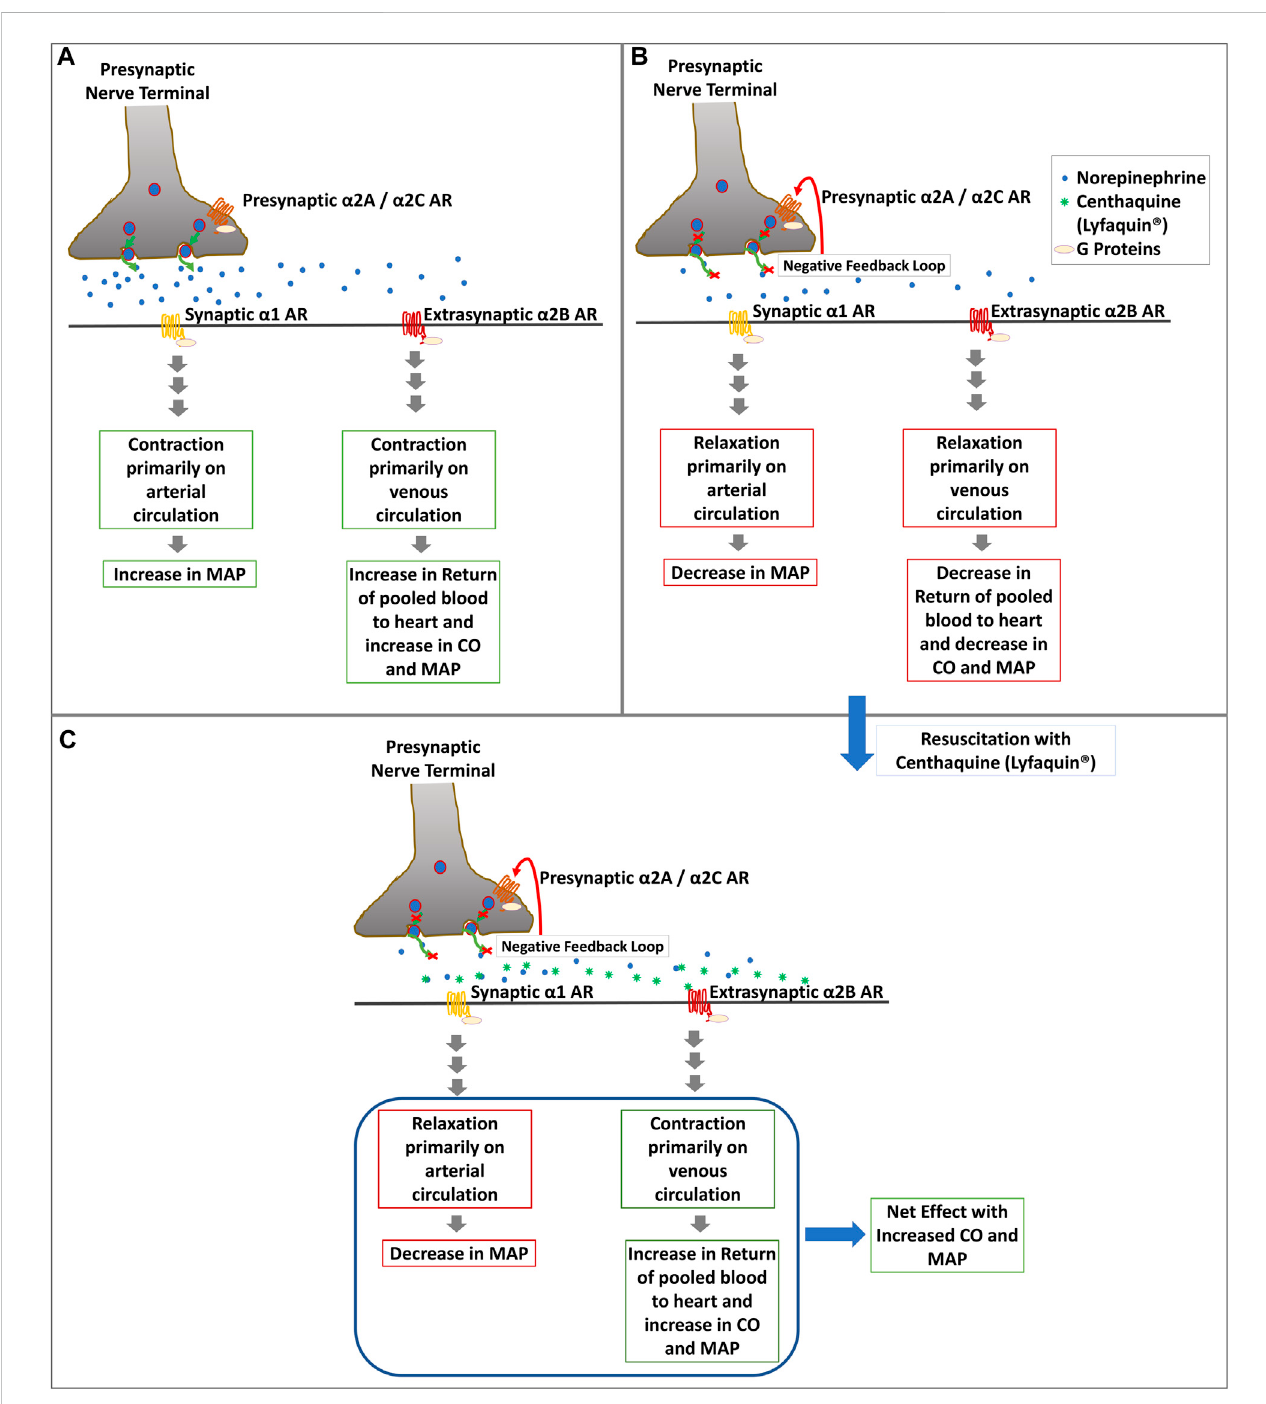
FIGURE 1 Diagrammatic representation of the potential mechanism of action of CQ (Lyfaquin ® ) resuscitation. (A) . Increase in blood pressure in the compensatory phase after shock most likely involves activation of presynaptic α 2A/ α 2C by epinephrine, which leads to the secretion of norepinephrine along with other neurotransmitters (not shown in the fi gure) from the presynaptic nerve terminal to postsynaptic nerve at the synapse and extrasynaptic tissue. α 1 ARs on postsynaptic nerves start downstream sympathetic signaling leading to contraction primarily on the arterial circulatory system and increasing MAP following activation with norepinephrine. Extrasynaptic α 2B ARs present primarily in the venous circulatory system also start contraction there and increase CO, which leads to an increase in MAP. However, the inherent feedback loop of norepinephrine and α 2A/ α 2C leads to the decompensatory phase in shock (showninpanelB). (B) .Inhibitionof α 2A/ α 2Cbynorepinephrinefollowingthenegativefeedback loopreducesthesecretionofnorepinephrineinthesynapse, which abrogates the effects described in panel A and leads to relaxation in blood vessels which causes reduced CO and MAP. (C) . Resuscitation with CQ (Lyfaquin ® ) helps prevent decompensation or restore the compensatory-like phase, with a net result of increased MAP. CQ is known to preferentially activate α 2BARs,whichincreasesthecontractionofthevenouscirculatorysystemleadingtoanincreaseinthereturnofpooledbloodtotheheartandthusincreasing the CO and MAP. CQ is also known to activate the central α 2A receptors, which would help reduce the SVR and increase tissue perfusion (not shown in this fi